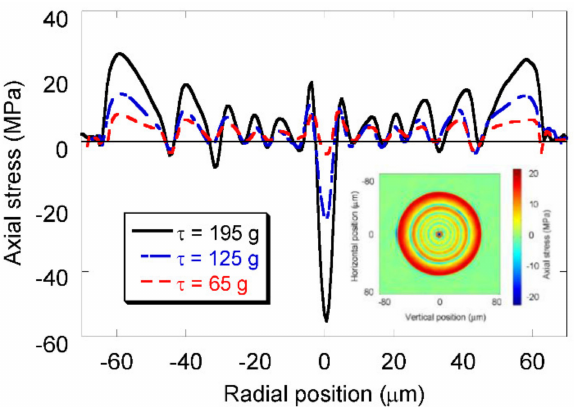
Figure 8. One-dimension tomographic stress profiles of the three fibers. Inset: 2D tomographic stress profile of the fiber drawn with a 125 g tension. Adapted with permission from ref. [118]. © 2005